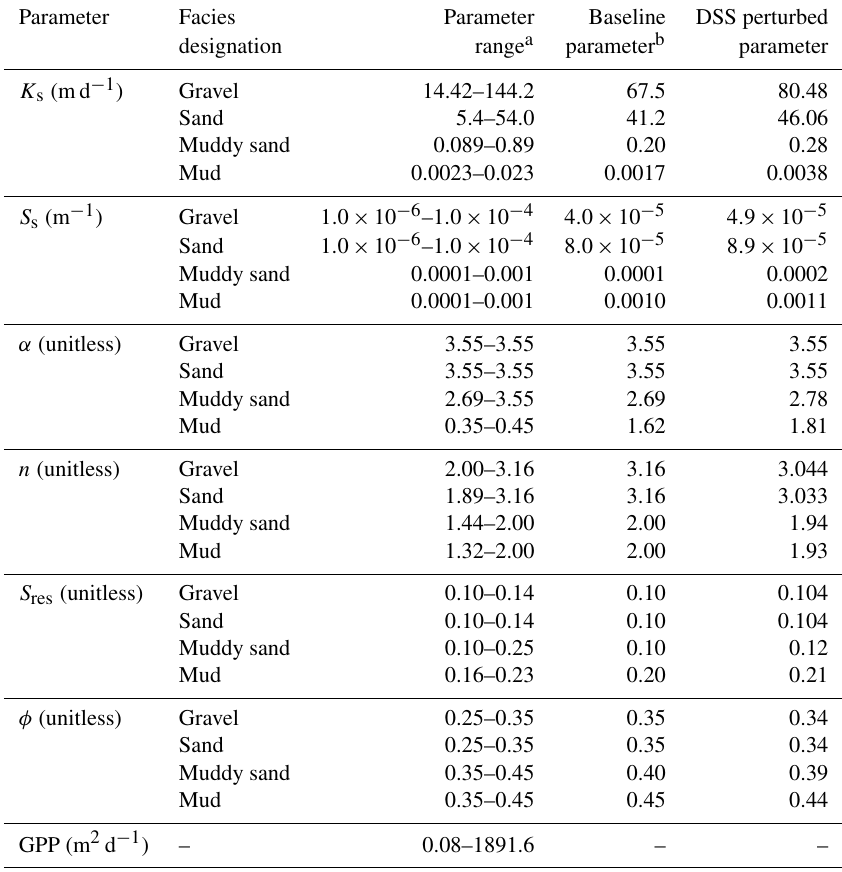
Table 4. Parameter ranges, along with baseline and DSS perturbed parameter values for hydraulic properties and the geologic proxy param- eter